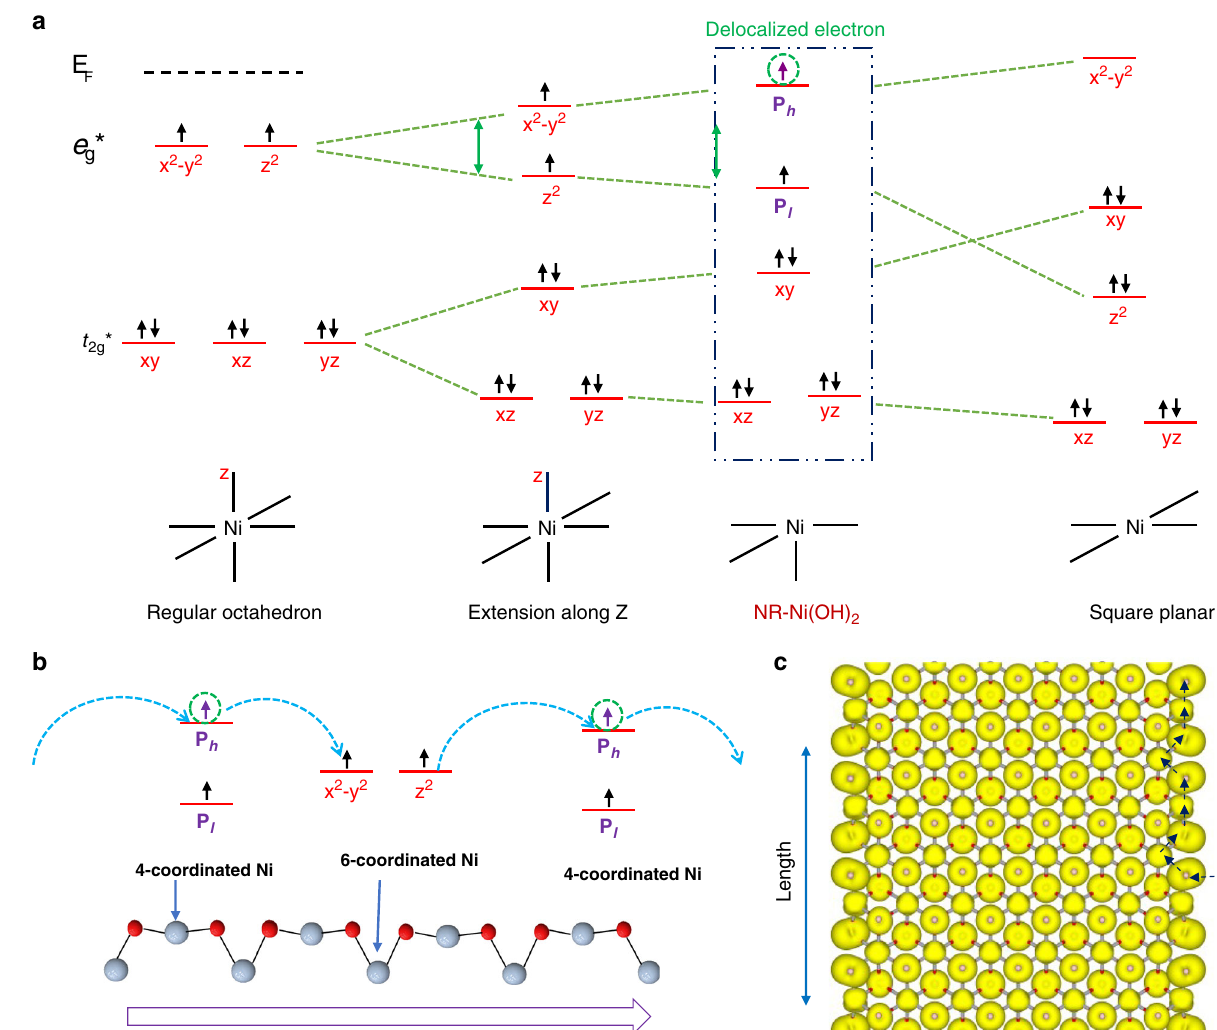
Fig. 4 Schematic of NR-Ni(OH) 2 electronic orbitals and charge transfer pathway. a t 2g * and e g * electronic orbitals of regular NiO 6 octahedron, NiO 6 octahedron extended along z axis, NR-Ni(OH) 2 , and NiO 4 square planar; b charge transfer process on alternating four-six-coordinated arrangement in NR-Ni(OH) 2 ; c isosurface of charge density of NR-Ni(OH) 2